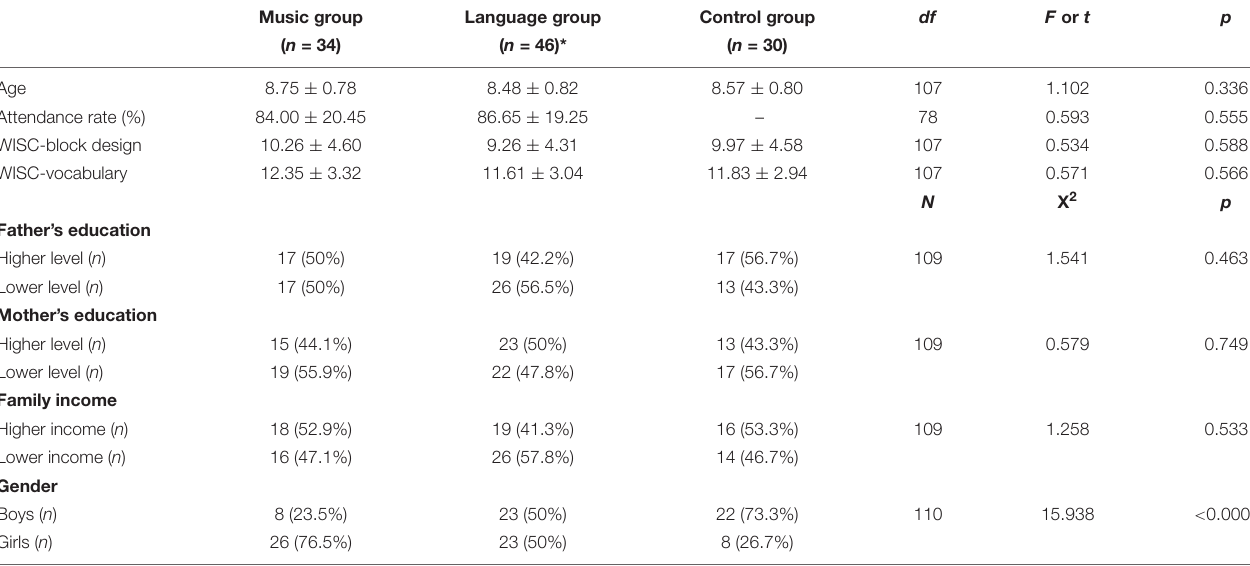
TABLE 1 | Descriptive statistics of the background variables in three groups at